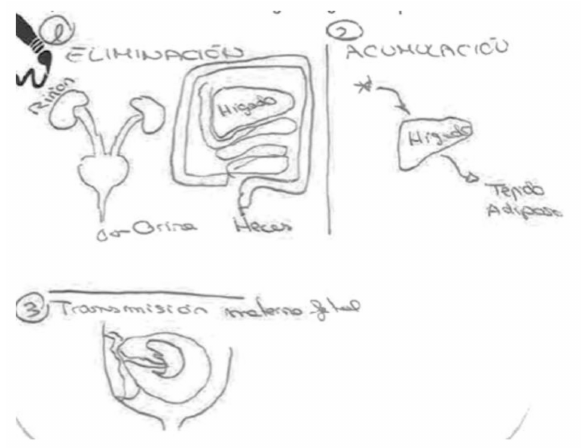
Figure 10. Breastfeeding, university education, nurse.